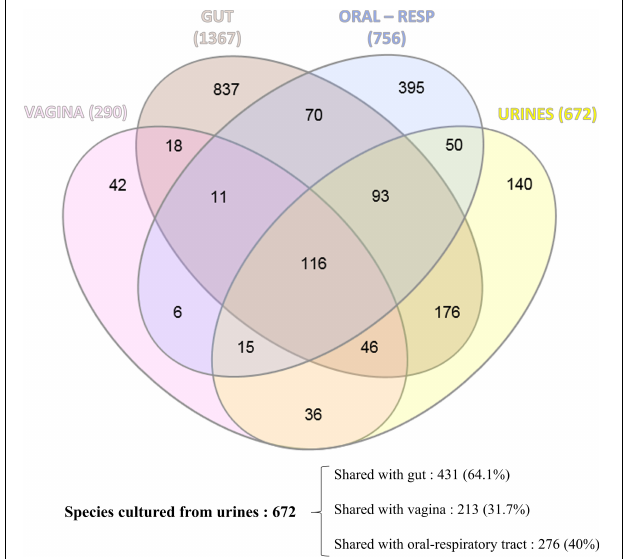
FIGURE 3 | Venn diagram showing the shared cultured species between the human urinary tract (this study and Morand et al., 2019), the human gut (Lagier et al., 2016), the human respiratory tract/oral cavity (Fonkou et al., 2018), and the human vagina (Diop et al., 2019).